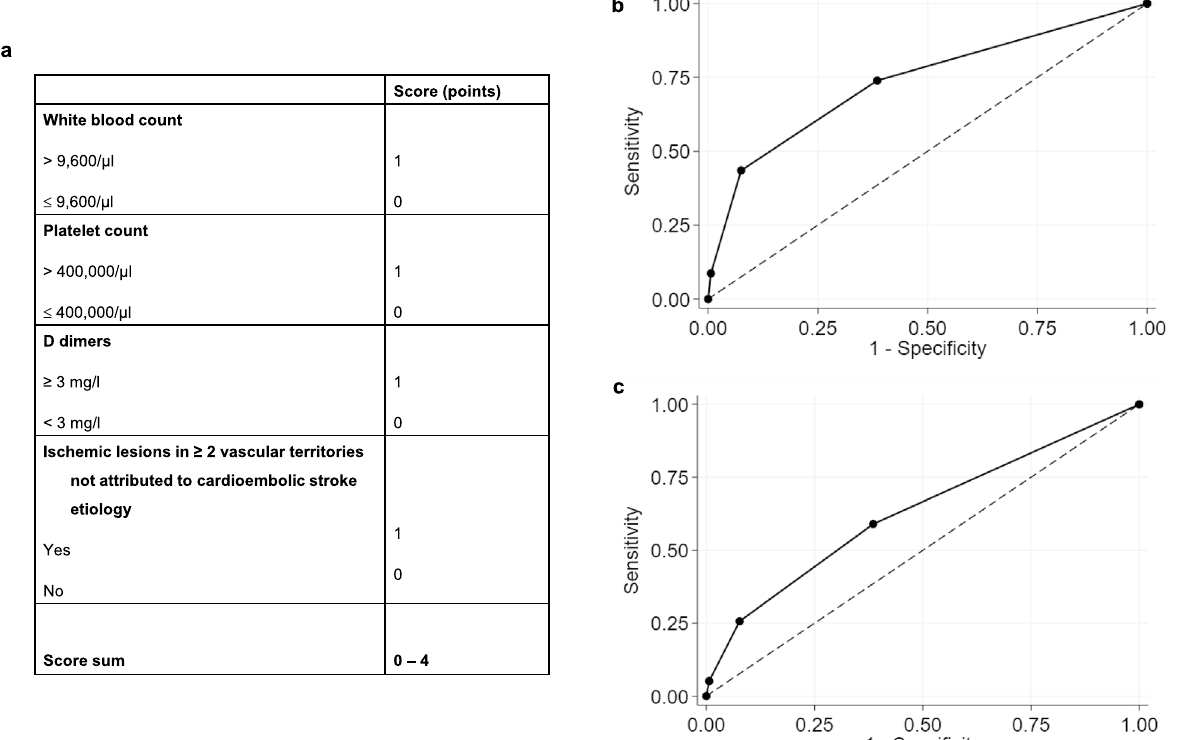
Figure 3. Score model for risk of cancer diagnosis after stroke. ( a – c ) Proposed score for estimation of risk of cancer diagnosis after stroke comprising levels of white blood count, platelet count, d-dimers, and occurrence of ischemic lesions in ≥ 2 vascular territories not attributed to cardioembolic stroke etiology ( a ). Receiver operating characteristic curves for the score for prediction of cancer diagnosed within 1 year ( b ) and 3 years after stroke ( c ) with data for all co-variables available for 794 patients, among them 23 and 39 diagnosed with cancer within 1 and 3 years after